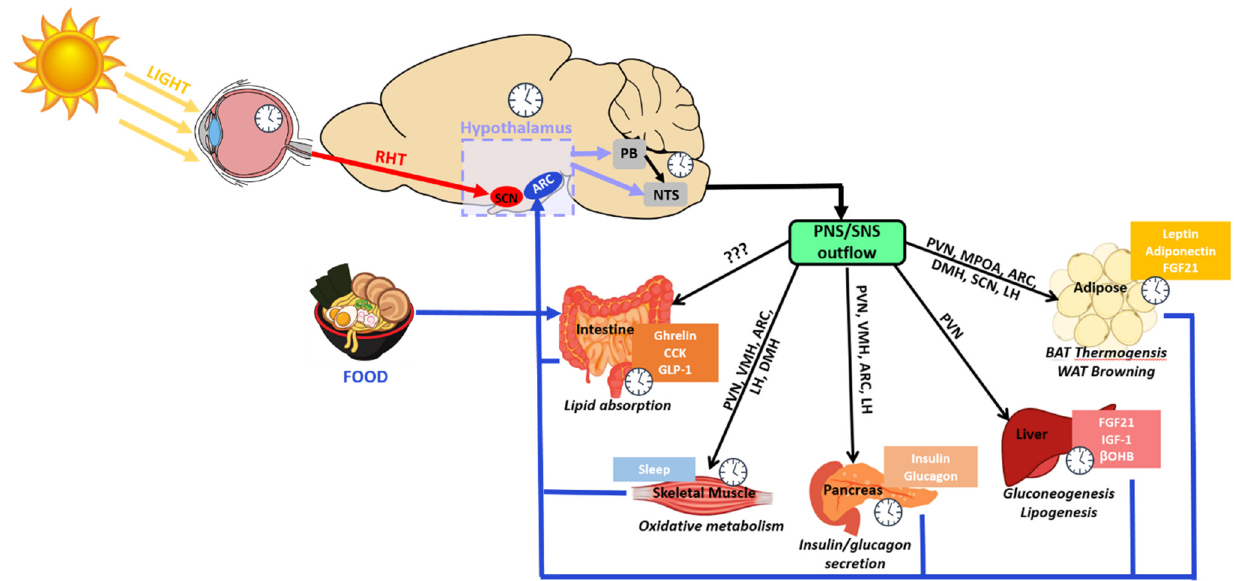
Figure 5. Hypothalamic-mediated circadian regulation of physiological functions. Powerful zeitgebers such as light and food have extensive effects on the circadian activity of cellular and tissue functions. The light-sensitive ipRGCs in the retina send signals to the master clock, the SCN, via the RHT. Food consumption stimulates various metabolic and digestive mechanisms which produce a variety of molecular signals and hormones. Nutrient-sensitive neurons in the circadian-regulated hypothalamus pick up the fluctuations in nutrients and hormones and relay the information downstream to the PB and the NTS which regulate the function of tissue processes through the parasympathetic and the sympathetic nervous system (PNS/SNS). With the exception of the intestines, which currently have not been found to have direct innervation from any hypothalamic nuclei, many metabolic-regulating tissues have direct or indirect innervations from various hypothalamic nuclei.